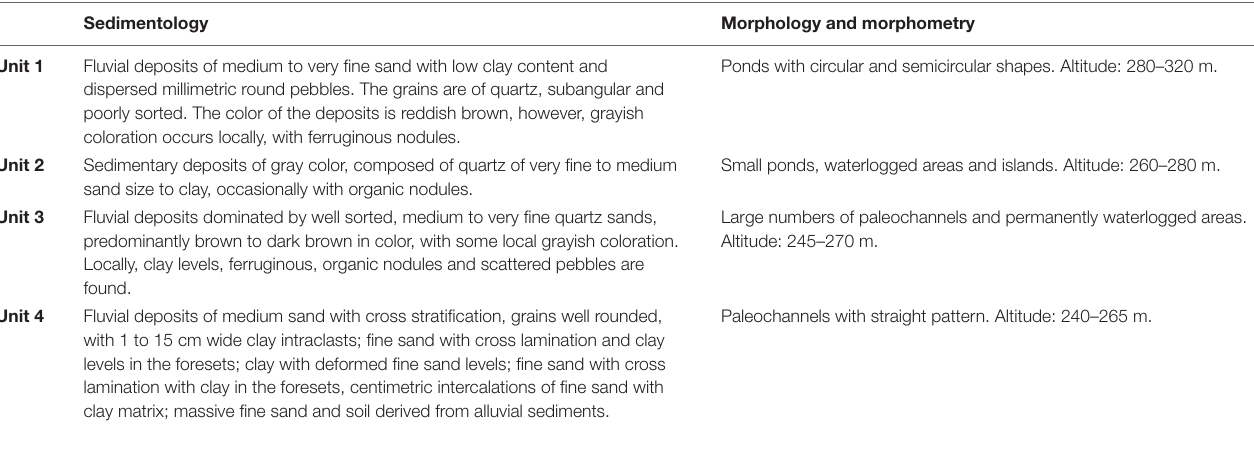
TABLE 2 | Main sedimentological, morphological and morphometric characteristics corresponding to the different geomorphological units.